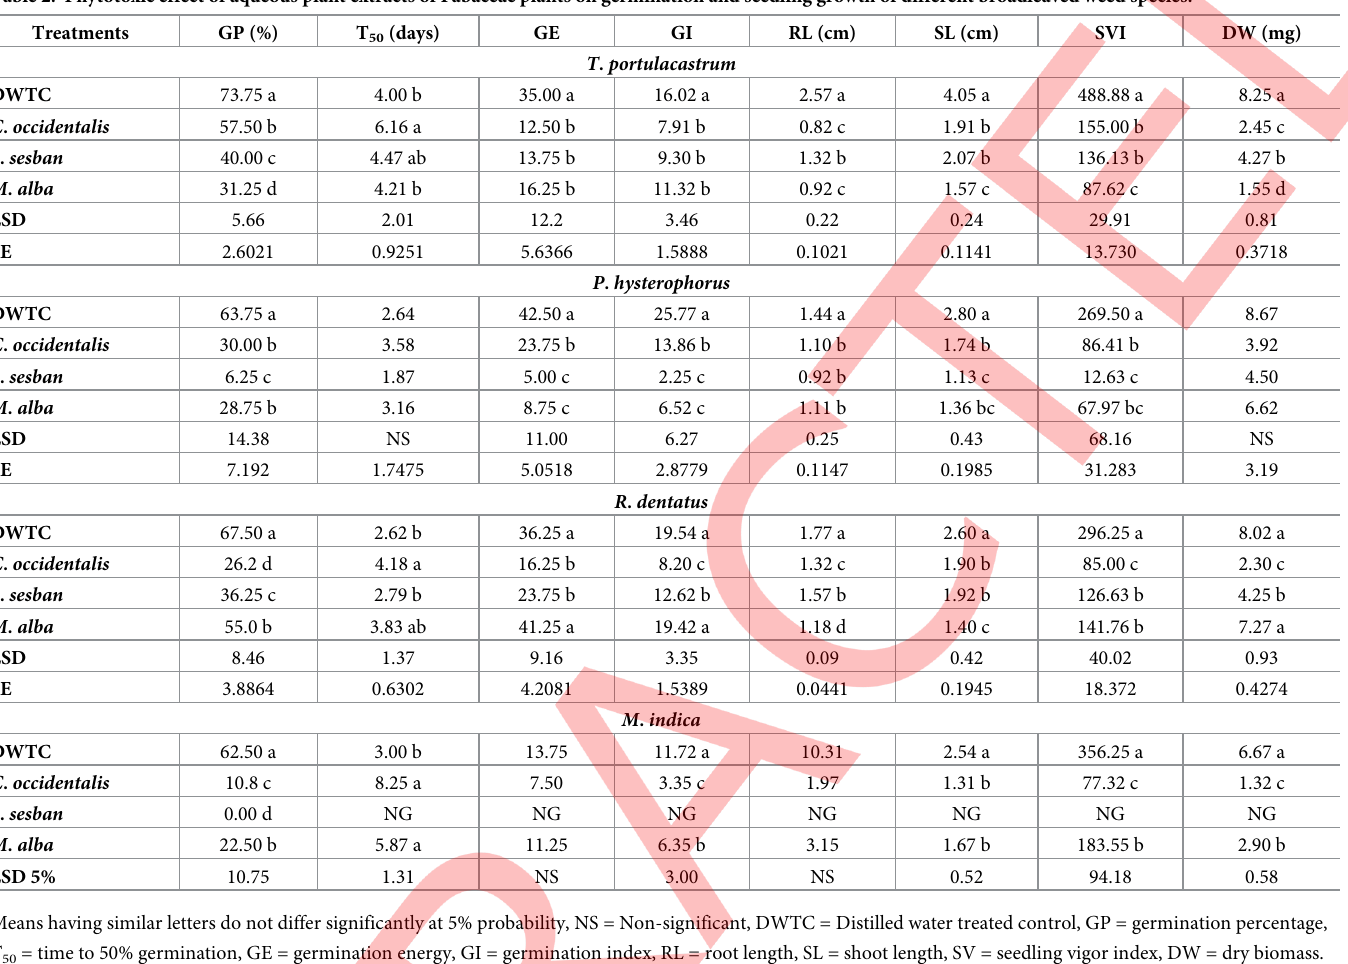
Table 2. Phytotoxic effect of aqueous plant extracts of Fabaceae plants on germination and seedling growth of different broadleaved weed species.